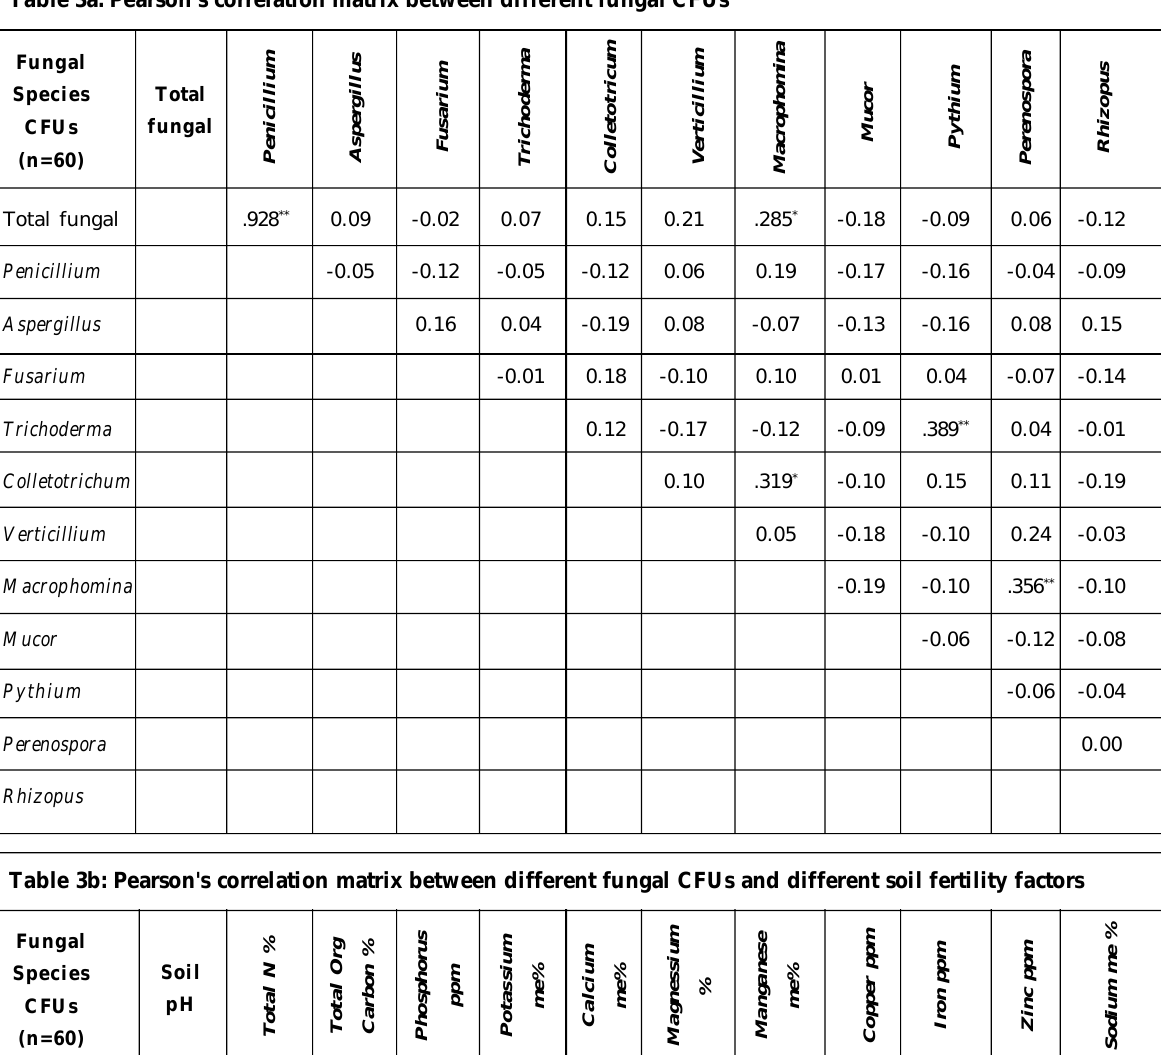
Table 3a: Pearson’s correlation matrix between different fungal CFUs Fungal Species CFUs